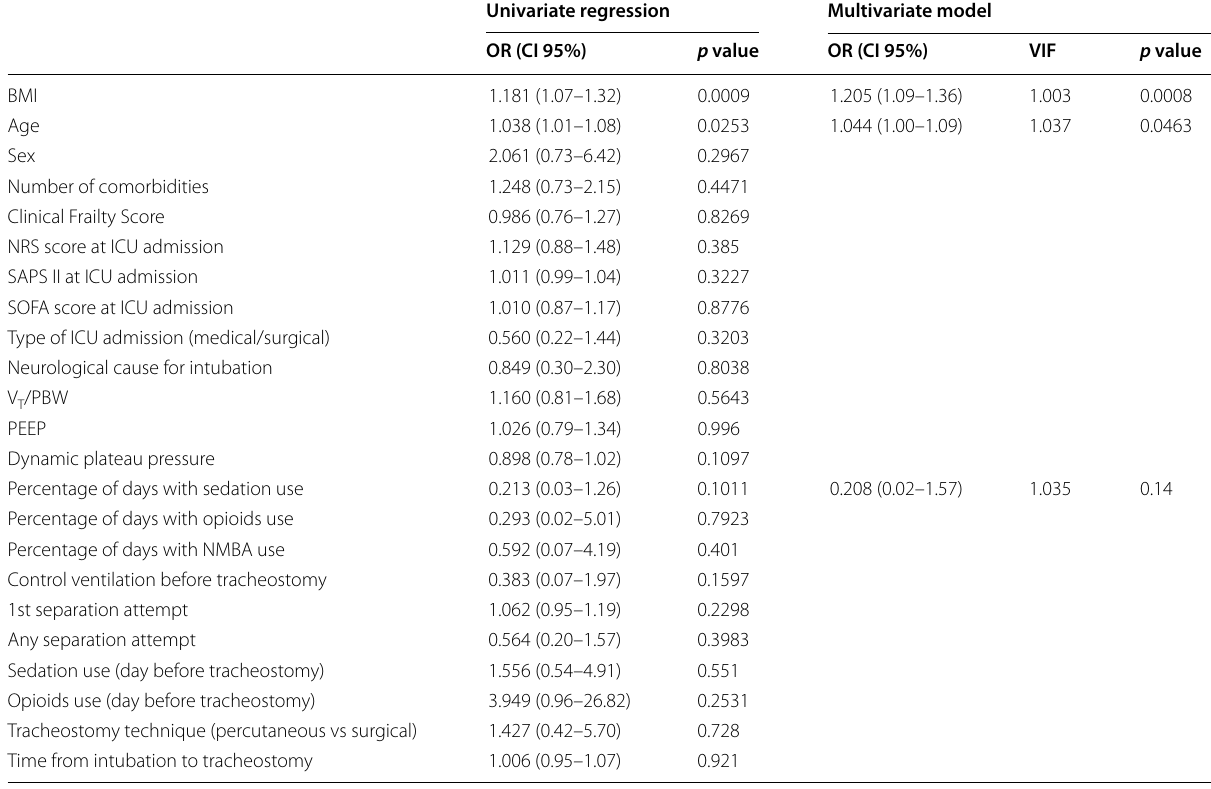
Table 4 Univariate analyses and multivariate logistic regression model for factors potentially associated with bad